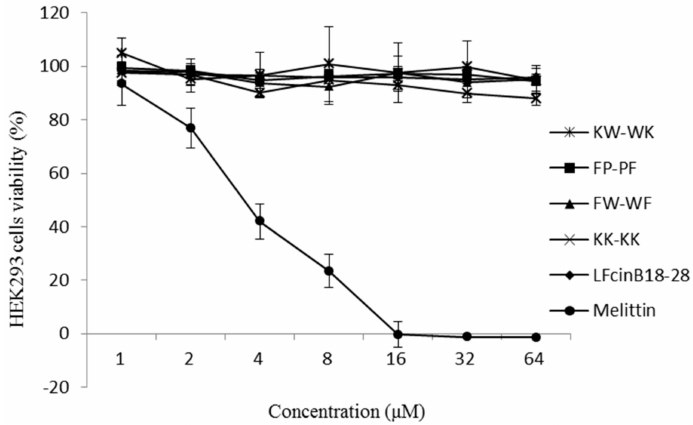
Figure 4. Cytotoxicity of each peptide against HEK293